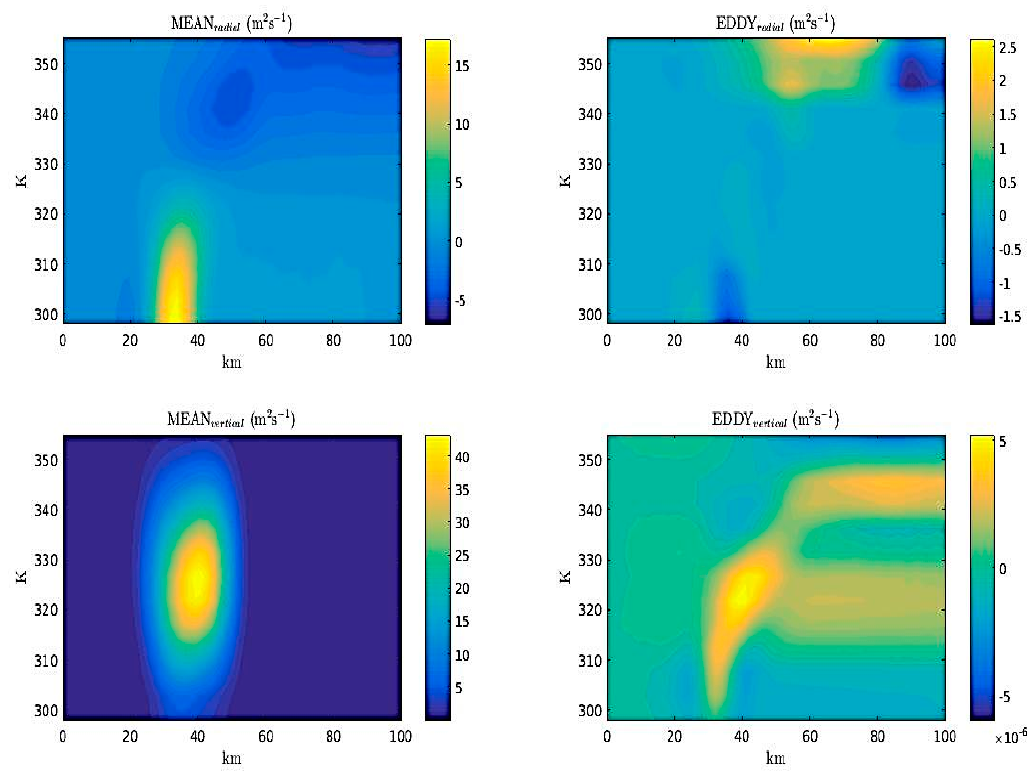
Figure 9. Azimuthal mean absolute angular momentum terms at (cid:1872) = 4 h . (cid:1839)(cid:1831)(cid:1827)(cid:1840) (cid:3045)(cid:3028)(cid:3031)(cid:3036)(cid:3028)(cid:3039) corresponds to radial mean term −((cid:1858) + (cid:2014)̅)(cid:1870)(cid:1848) (cid:3019) (cid:3364)(cid:3364)(cid:3364) ; (cid:1839)(cid:1831)(cid:1827)(cid:1840) (cid:3049)(cid:3032)(cid:3045)(cid:3047)(cid:3036)(cid:3030)(cid:3028)(cid:3039) corresponds to the vertical mean term (cid:1831)(cid:1830)(cid:1830)(cid:1851) (cid:3045)(cid:3028)(cid:3031)(cid:3036)(cid:3028)(cid:3039) corresponds to the radial eddy term −(cid:1870)(cid:2026)(cid:1842) ∗ (cid:1848) (cid:3019)∗ (cid:3364)(cid:3364)(cid:3364)(cid:3364)(cid:3364)(cid:3364)(cid:3364)(cid:3364) ; and (cid:1831)(cid:1830)(cid:1830)(cid:1851) (cid:3049)(cid:3032)(cid:3045)(cid:3047)(cid:3036)(cid:3030)(cid:3028)(cid:3039) corresponds to the (cid:2034)(cid:1865)′/(cid:2034)(cid:2016)(cid:3364)(cid:3364)(cid:3364)(cid:3364)(cid:3364)(cid:3364)(cid:3364)(cid:3364)(cid:3364)(cid:3364)(cid:3364)(cid:3364) vertical eddy term (cid:2016)(cid:4662)